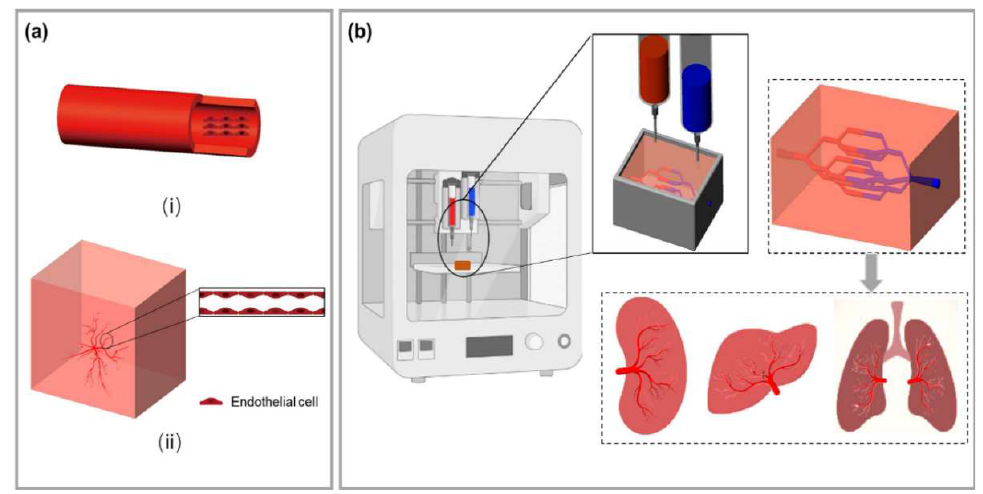
Figure 2. ( a ) Traditional tissue engineering blood vessel construction method. ( i ) Tubular scaffolds were prepared before endothelial cells (ECs) were seeding on the inner surface of the scaffolds; ( ii ) Stimulating capillary angiogenesis directly within the tissue engineered scaffolds. ( b ) A general depiction of 3D bioprinting for vascularized tissue construction. Multi-scale branched blood vessels can be obtained by printing ECs in a scaffold, and an ideal organoid can be obtained after in vitro cultures.